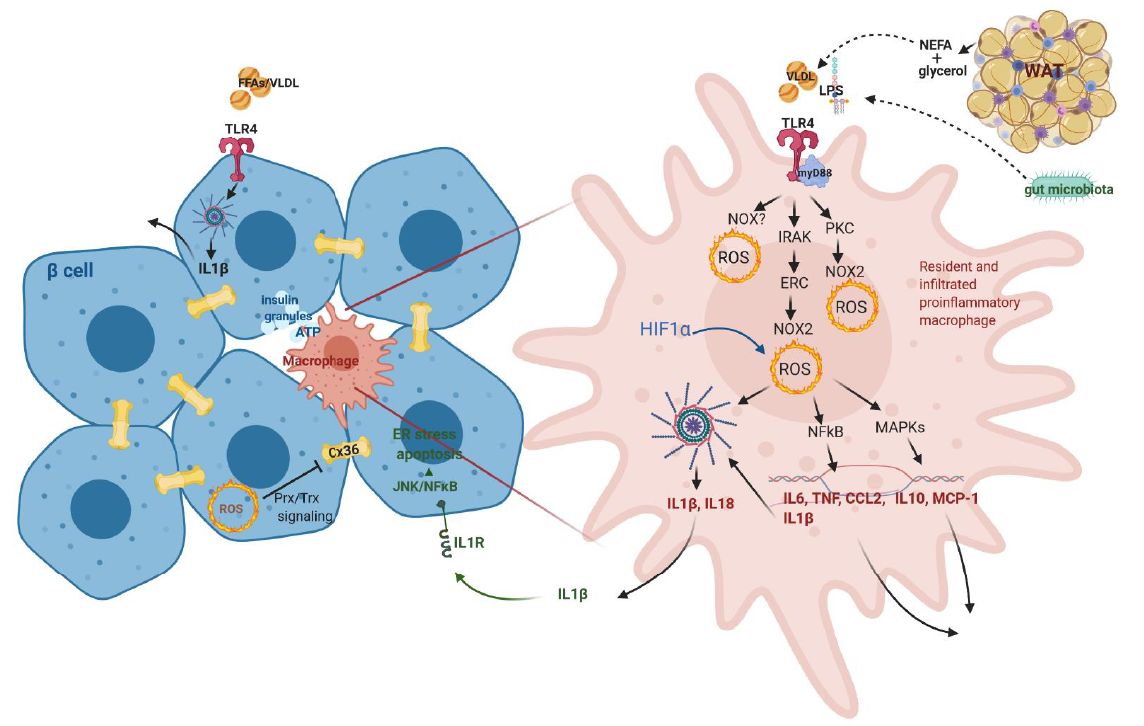
Figure 5. Activation of proinflammatory macrophages involves prooxidative signaling. Altered insulin secretion from β -cells signals to activation and differentiation of resident and infiltrating macrophages in islets, the latter one being also activated through TLR4 by lipoproteins from WAT and microbiota-derived metabolites. Activation induces prooxidative metabolism required for inflammasome formation and production of proinflammatory cytokines/chemokines, which target β-cells towards dysfunction. Upon chronic nutritional overload, also β-cells can form inflammasome and secrete IL1β. Gap junctions (composed of CX36) between β-cells of the pancreatic islet are suggested to reflect β-cell redox status and thus regulate islet insulin secretion. TLR4—Toll-like receptor 4, WAT—white adipose tissue, IL1β—interleukin 1 β, CX36—connexin 36.